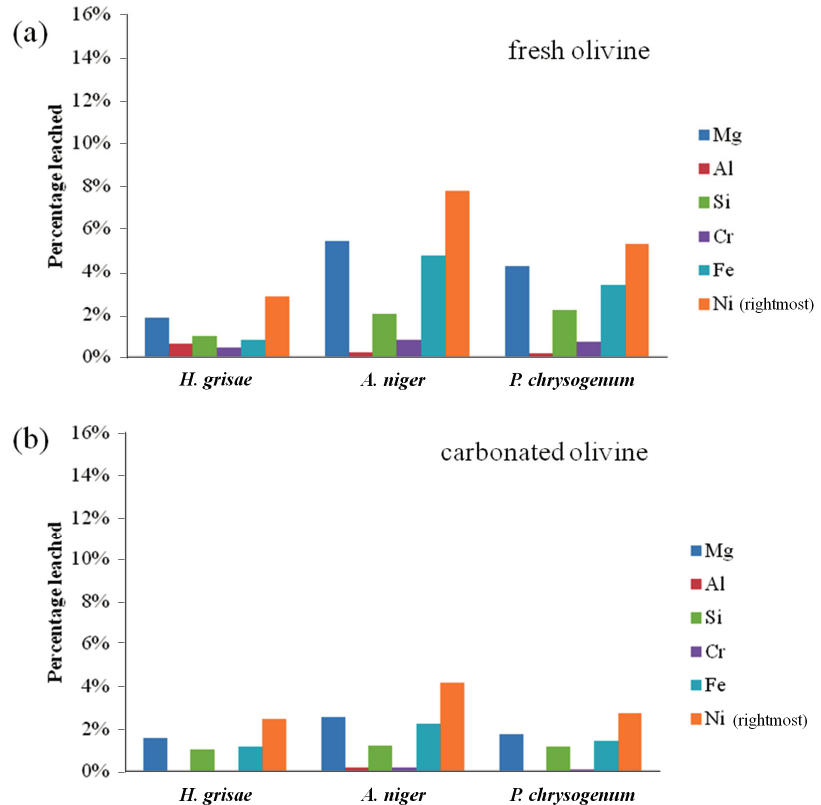
Figure 3. ( a ) Elemental leaching extent from fresh olivine by sterile biogenic substances derived from different fungi over 7 days; and ( b ) elemental leaching extent from carbonated olivine by sterile biogenic substances derived from different fungi over 7